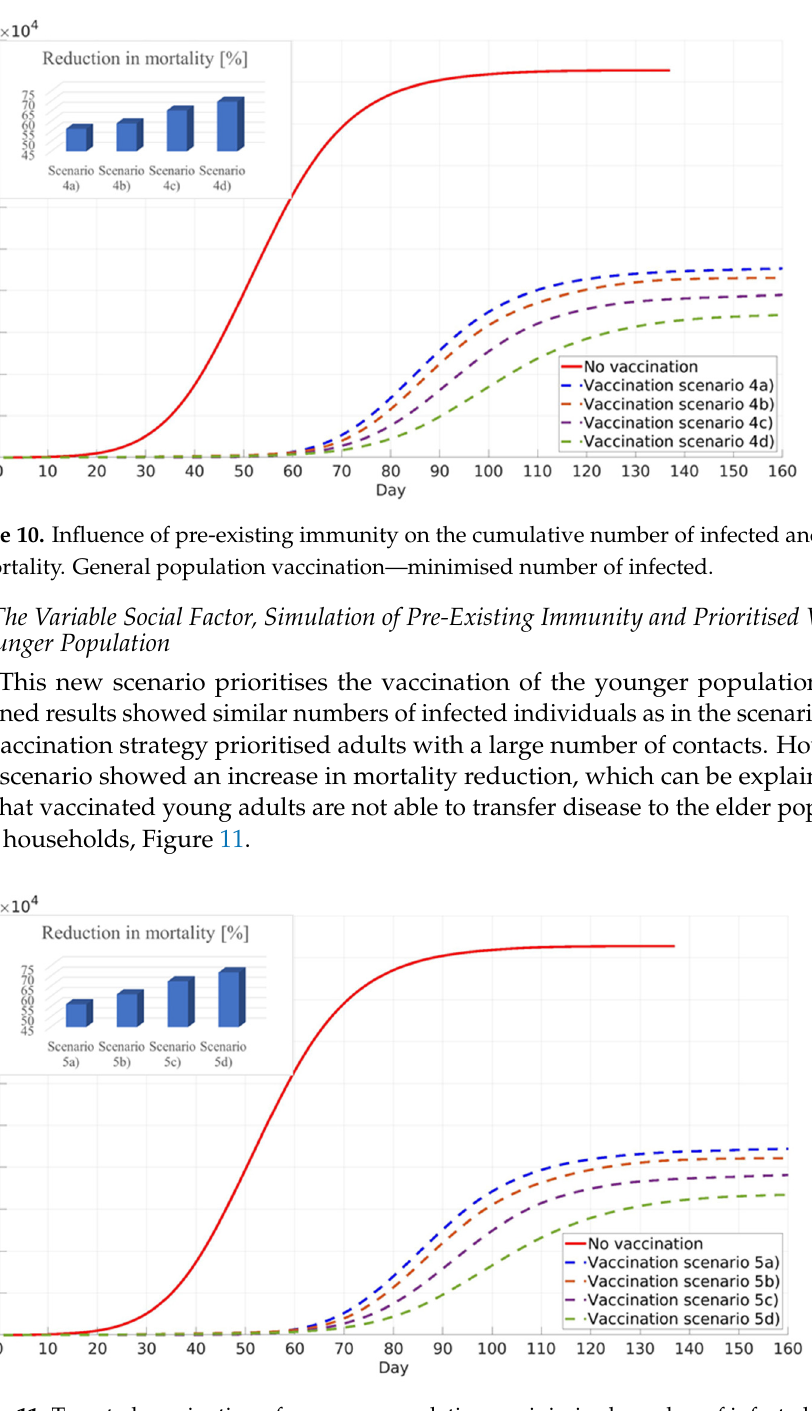
Figure 11. Targeted vaccination of younger population—minimised number of infected.